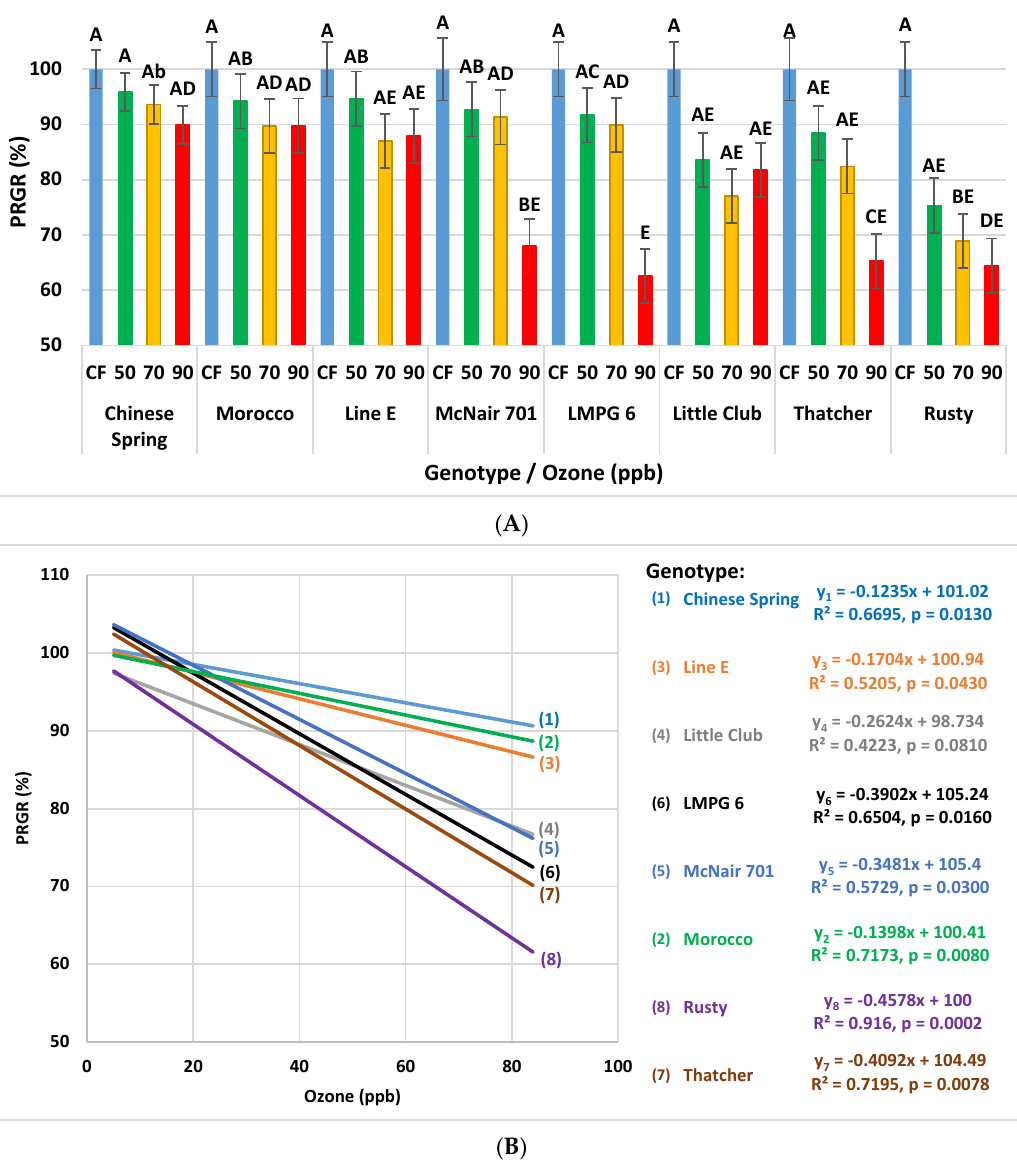
Figure 14. Percent relative growth rate (PRGR) [relative dry matter accumulation rate (RDMAR) under O 3 treatment referenced to their RDMAR in charcoal-filtered air (CF)], of eight rust near-universal susceptible genotypes at different O 3 levels of 50, 70, 90 ppb (actual achieved treatments were 5, 46, 65, and 84 ppb, respectively) for 14 days (12 h/day), in OPECs (at 25 °C and 50% RH): ( A ) Interaction of genotype and O 3 concentration on PRGR, values are means (±SE) statistically separated using Tukey-Kramer adjustment for multiple comparisons, and means marked with the same letter are not significantly diff erent at α = 0.05; ( B ) PRGR regression lines on O 3 concentration.